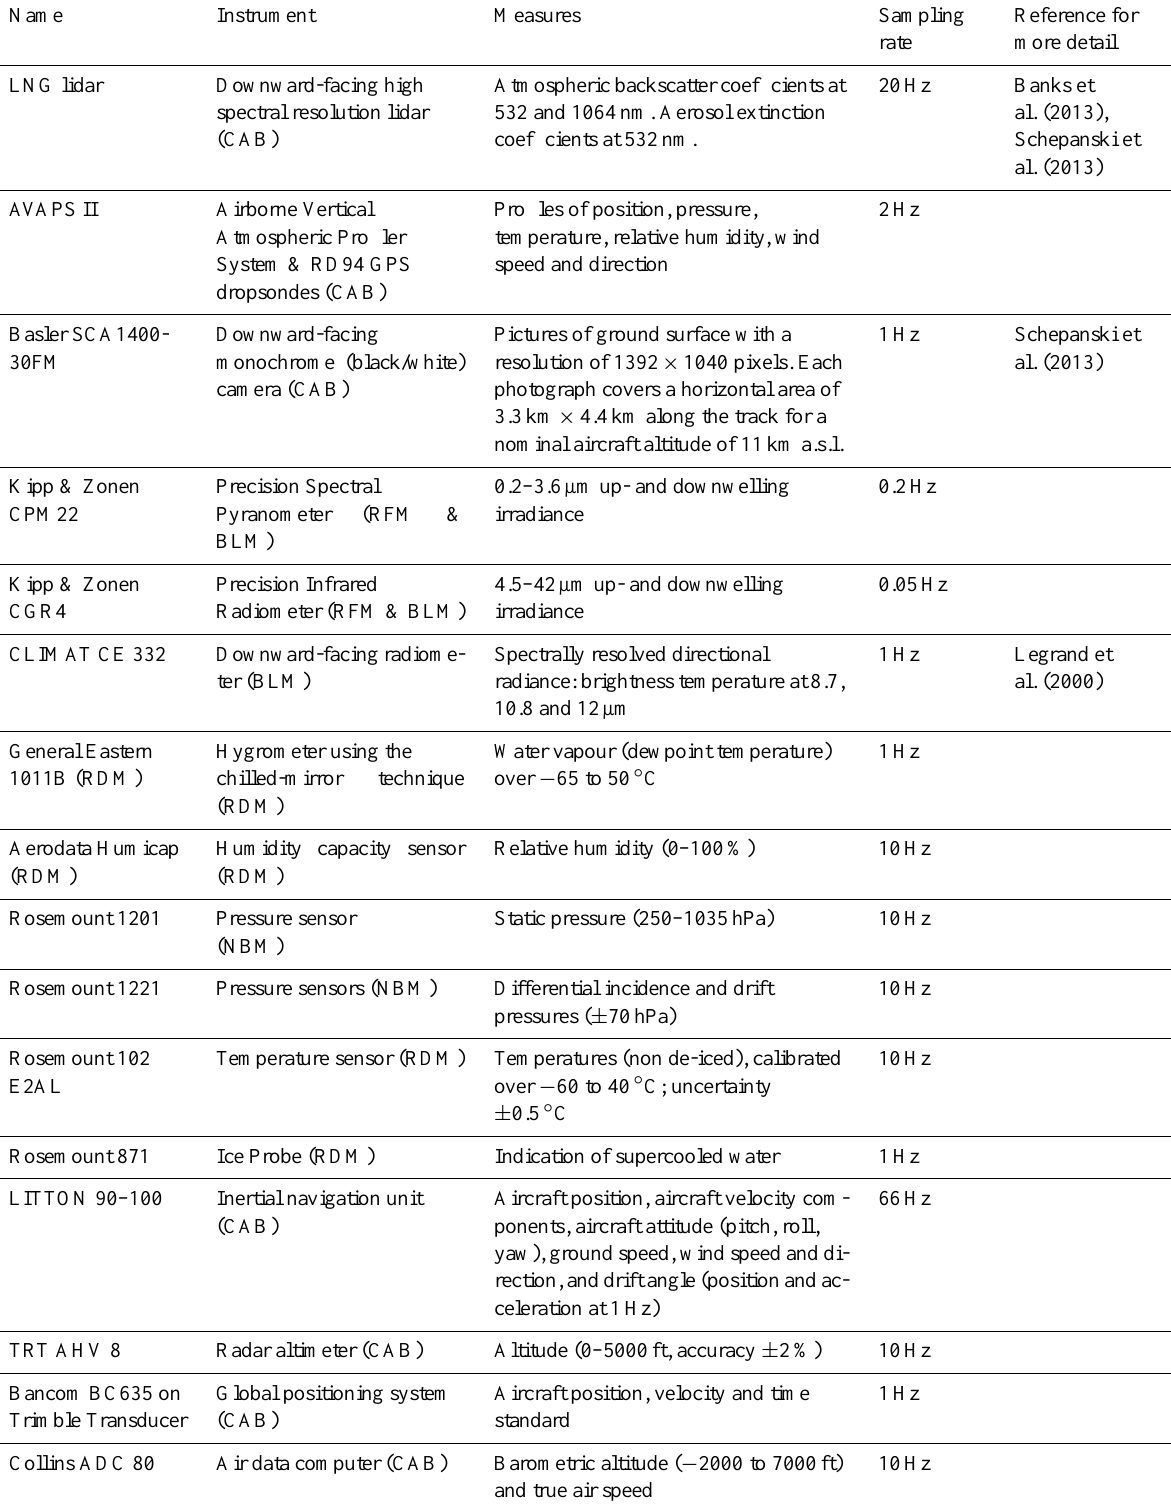
Table 3. Instruments onboard the SAFIRE Falcon 20 during the 2011 IOP. NBM is nose boom mounted; CAB is inside aircraft cabin; RDM is radome mounted, BLM is belly mounted; RFM is roof